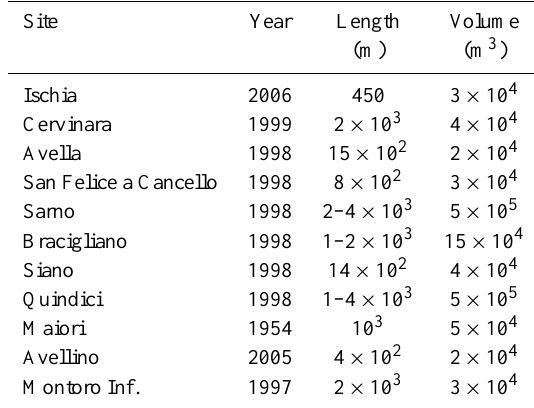
Table 1. Features of some recent flowslides in the Campania Region (Versace et al.,